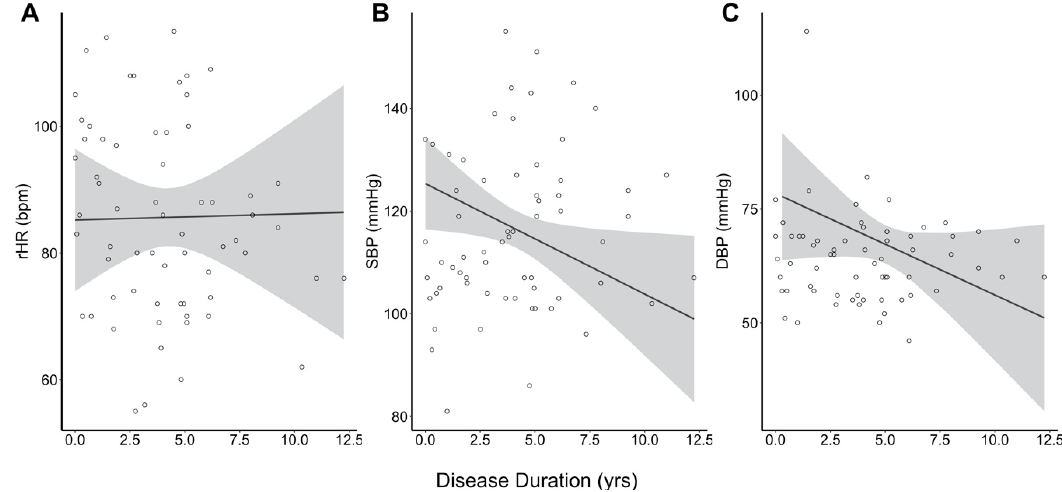
Figure 2. ( A ) Disease duration among patients with JOHD did not significantly predict rHR. ( B